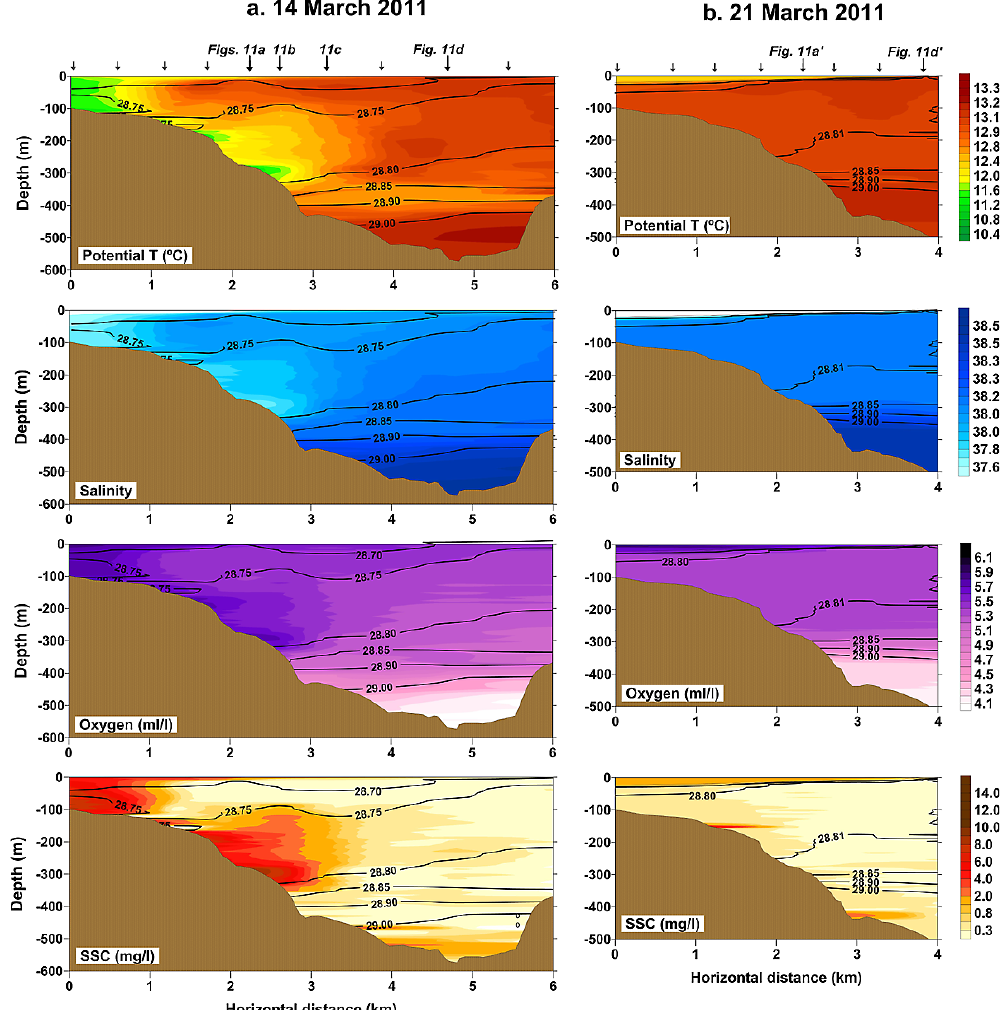
Fig. 6. Distribution of water column properties in the Cap de Creus Canyon during two across-canyon (=orthogonal to the canyon axis) CTD transects conducted on 14 and 21 March 2011 (left and right panels, respectively). From top to bottom: water salinity, potential temperature, dissolved oxygen concentration and suspended sediment concentration. Isolines of water density anomaly are overlaid on all these contours. Arrows on top mark the temporal distribution of CTD casts used to create the